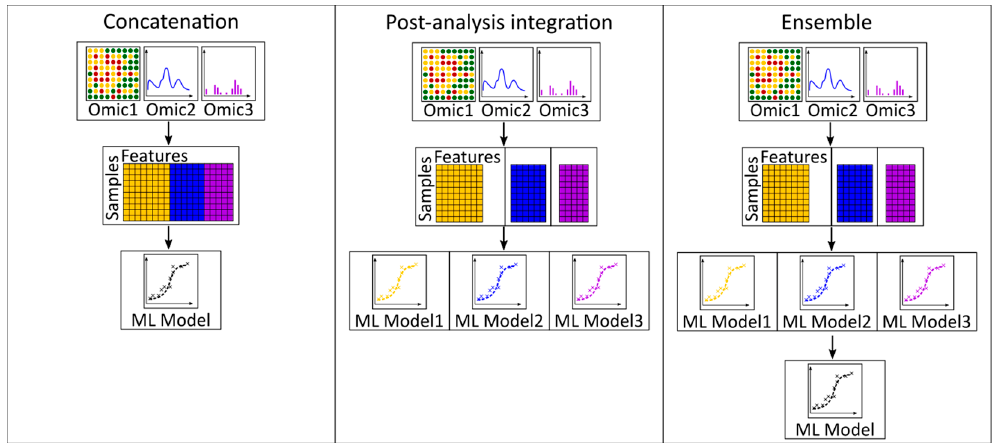
Figure 3. Strategies for multi-omics integration. Omics data can be combined in a single matrix with all omics features, called ‘concatenation,’ or each omics measurement is separately analyzed, called ‘post-analysis integration,’ or the data is concatenated, but instead of a single ML model, many models are trained and their results are combined to calculate the optimal response, called ‘ensemble.’.